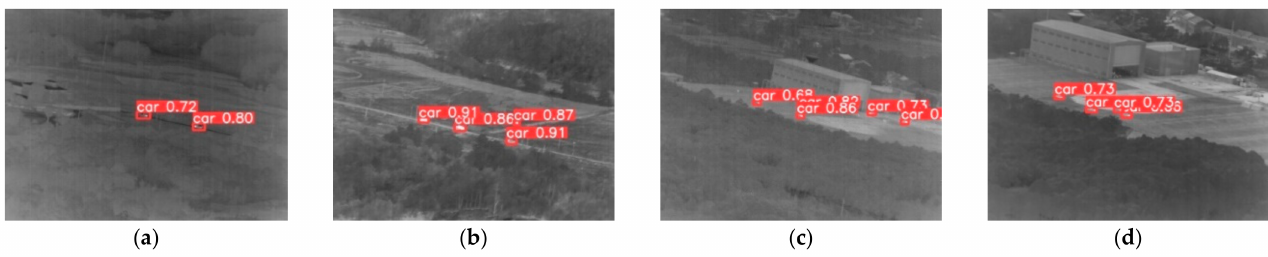
Figure 9. 8-3 DenseBlock detection results. ( a ) Scene 1. ( b ) Scene 2. ( c ) Scene 3. ( d ) Scene 4.